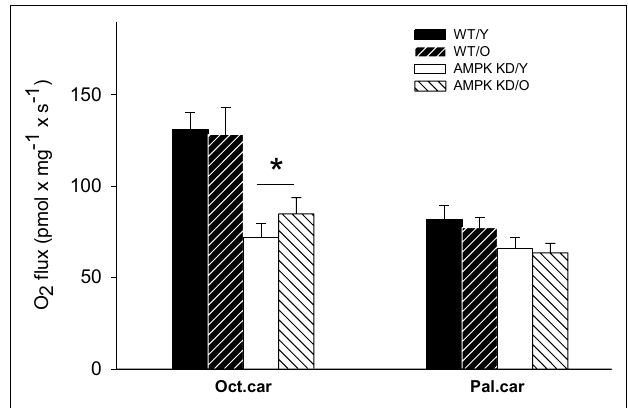
FIGURE 3 | Carnitine palmitoyl transferase isoforms 1A (CPT1A) and 1B (CPT1B) as well as carnitine palmitoyl transferase 2 (CPT2) in heart muscle samples from wild type mice (WT) and dominant negative AMPK α 2 (AMPK KD) mice. Young (Y: 19–22weeks) and old (O: 76–91weeks) mice were studied in both groups. *Different fromWT/Y ( P < 0.05).